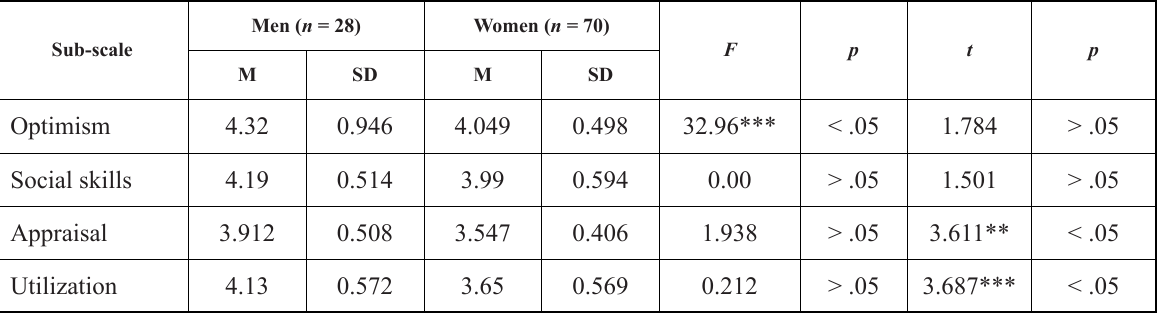
Table 2. Teacher self-report of emotional abilities estimates by gender